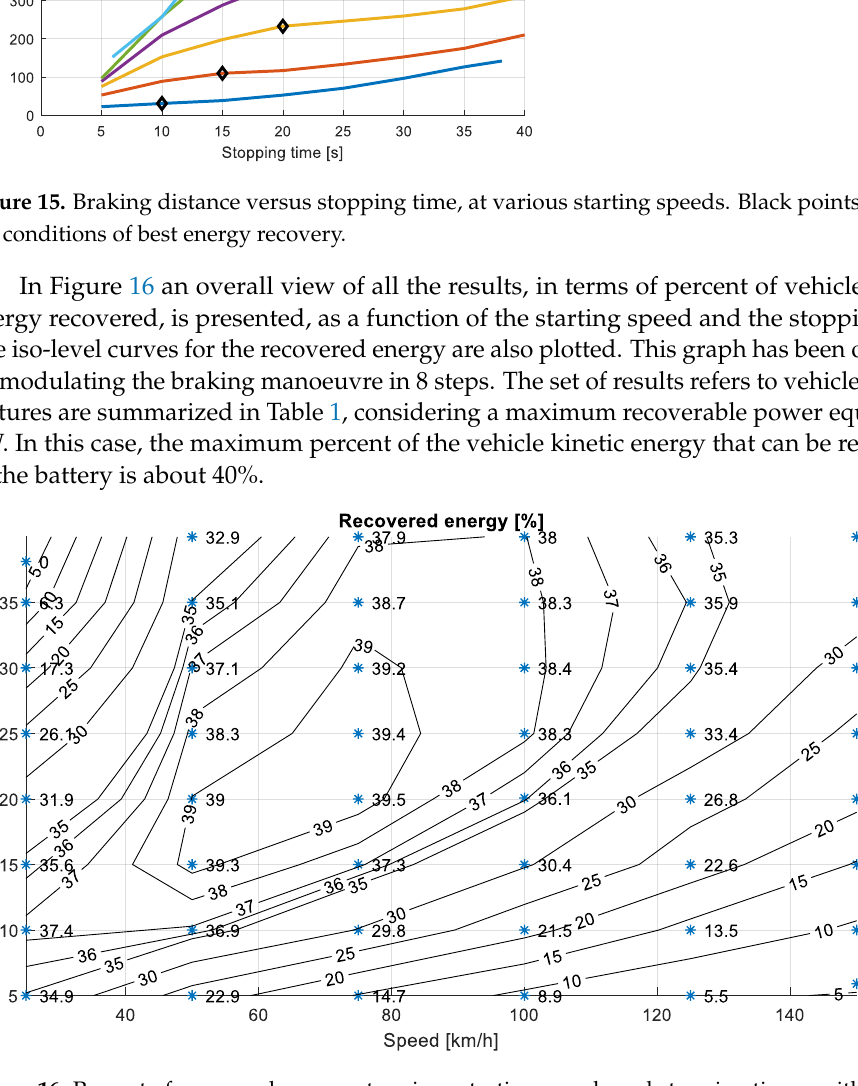
Figure 16. Percent of recovered energy at various starting speeds and stopping times, with contour plots. Results obtained with 8 steps in braking manoeuvre.